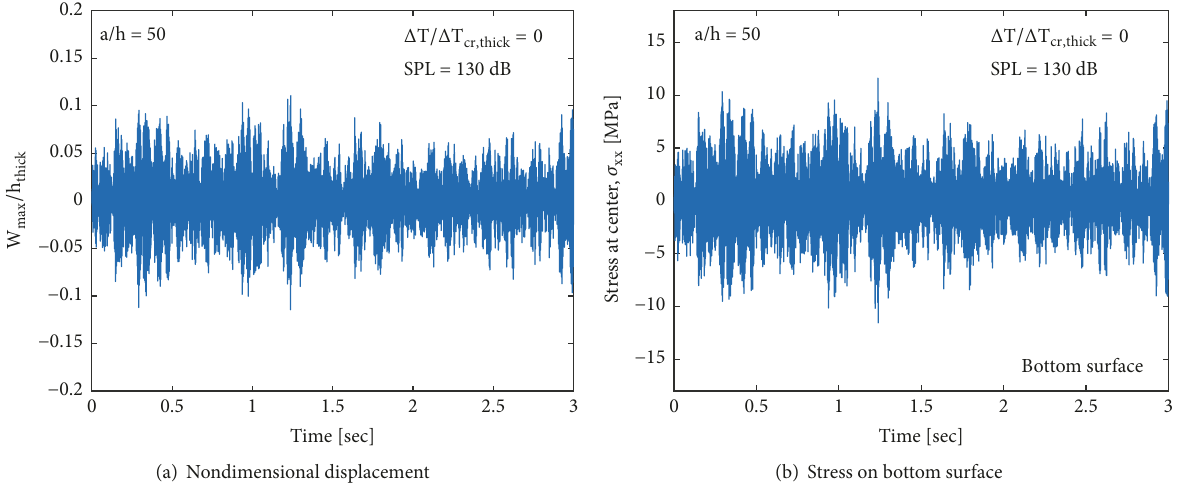
Figure 10: Small random vibrations about flat position (a/h = 50).